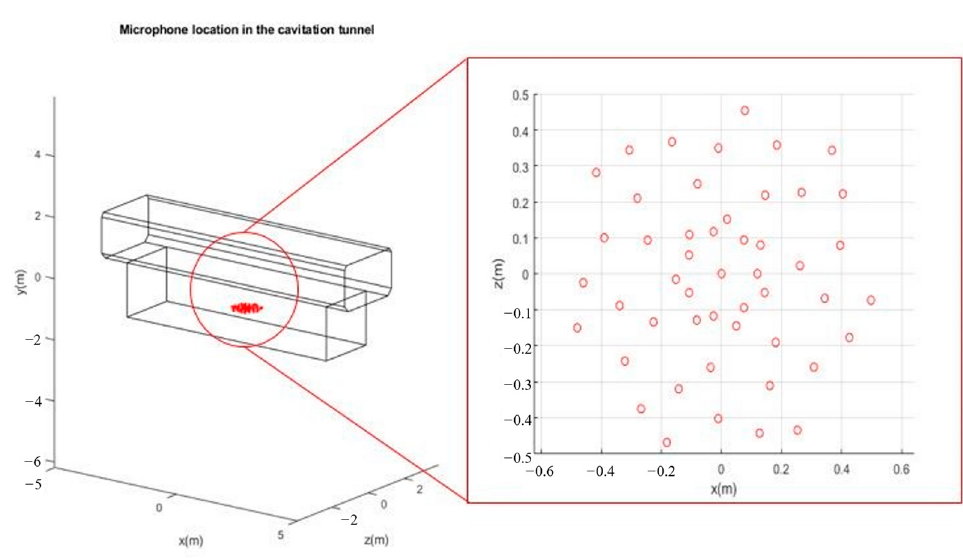
Figure 17. Microphone locations in the large cavitation tank model.